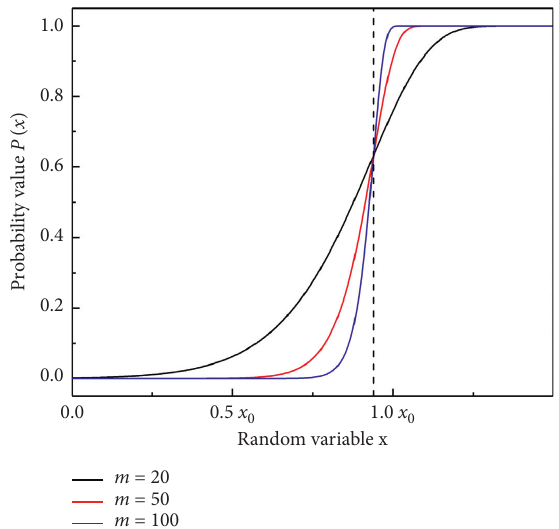
Figure 4: The curves of the probability of Weibull